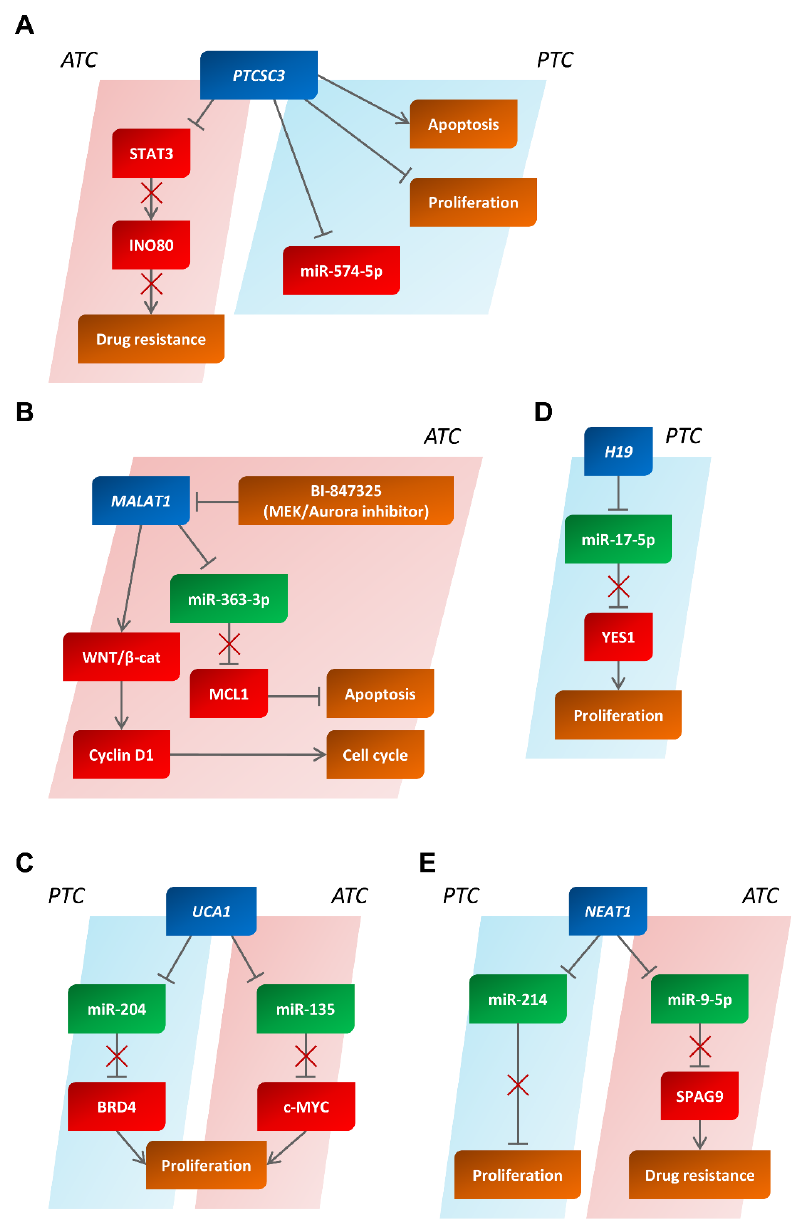
Figure 5. The landscape of lncRNAs deregulated in human papillary and anaplastic thyroid carci- nomas. Schematic representation of the main lncRNAs involved in human papillary and anaplastic thyroid carcinomas. The suppressive role of PTCSC3 ( A ) and the oncogenic behavior of MALAT1 ( B ), UCA1 ( C ), H19 ( D ), and NEAT1 ( E ) are schematically reported in the figure. In red and in green, the partners with an oncogenic or anti-oncogenic behavior are reported, respectively. PTC, papillary thyroid carcinoma; ATC, anaplastic thyroid carcinoma.